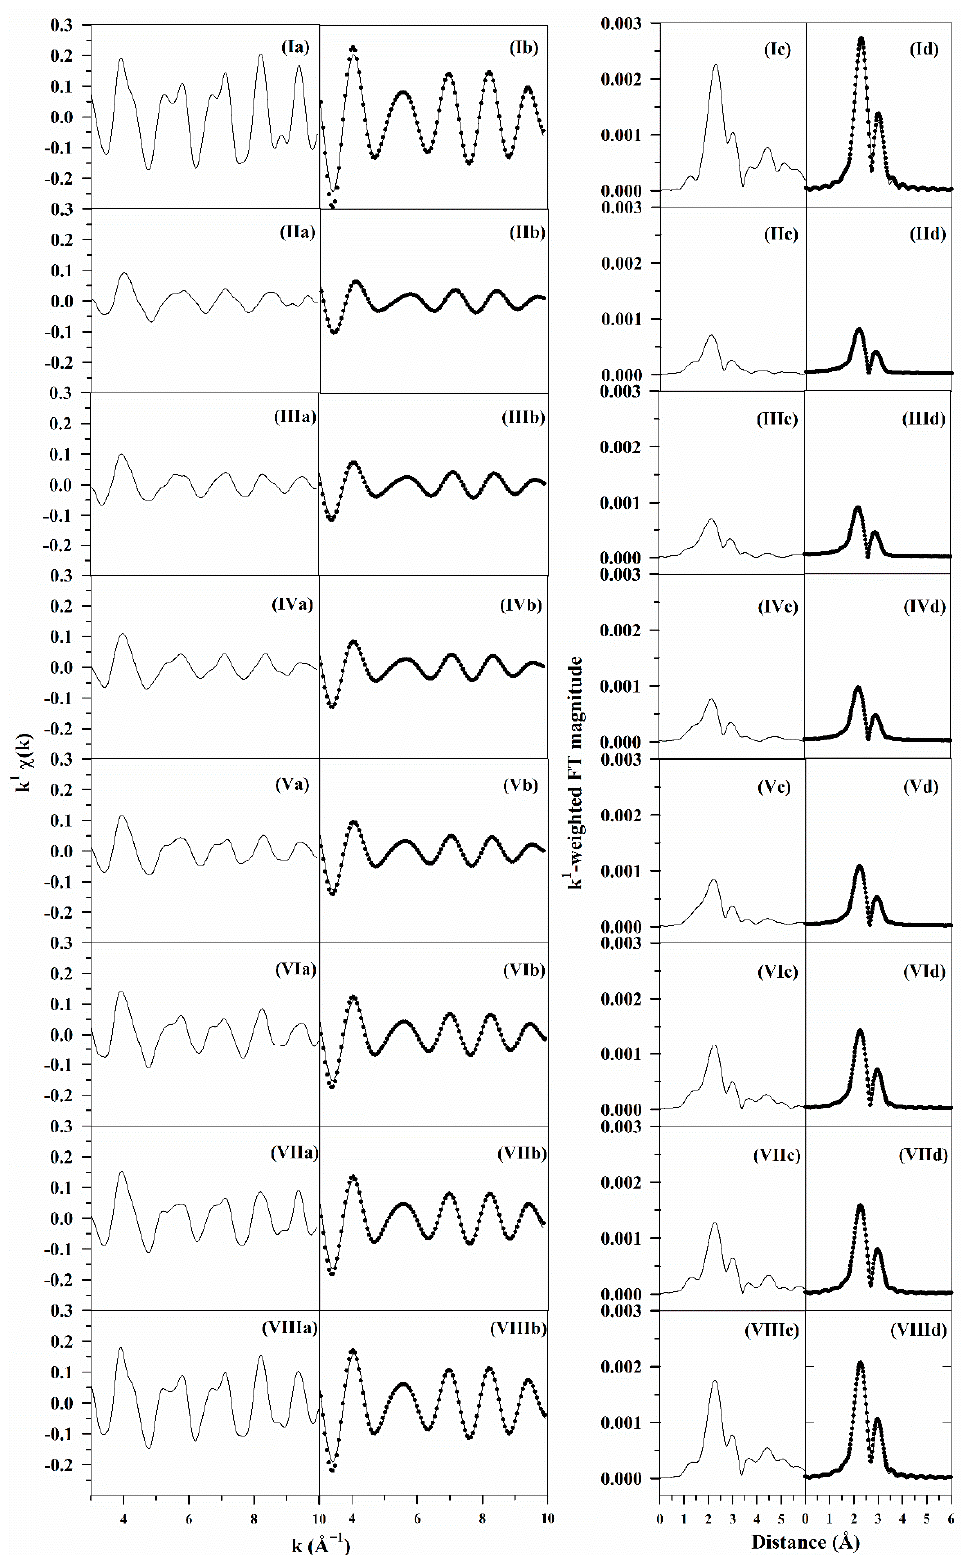
Figure 7. EXAFS fittings, including ( a ) raw k 1 -weighted χ (k) data, ( b ) (solid line) filtered k 1 -weighted χ (k) data and (filled circles) results of the fittings, ( c ) raw and ( d ) filtered k 1 -weighted Fourier transform magnitude (solid line) data and (filled circles) results of the fittings for ( I ) Pt 0 foil, ( II ) 2%Pt/ZrO 2 , and 2%Pt/ZrO 2 with ( III ) 0.93%Rb, ( IV ) 1.86%Rb, ( V ) 2.79%Rb, ( VI ) 4.65%Rb, ( VII ) 5.58%Rb, and ( VIII ) 9.29%Rb.